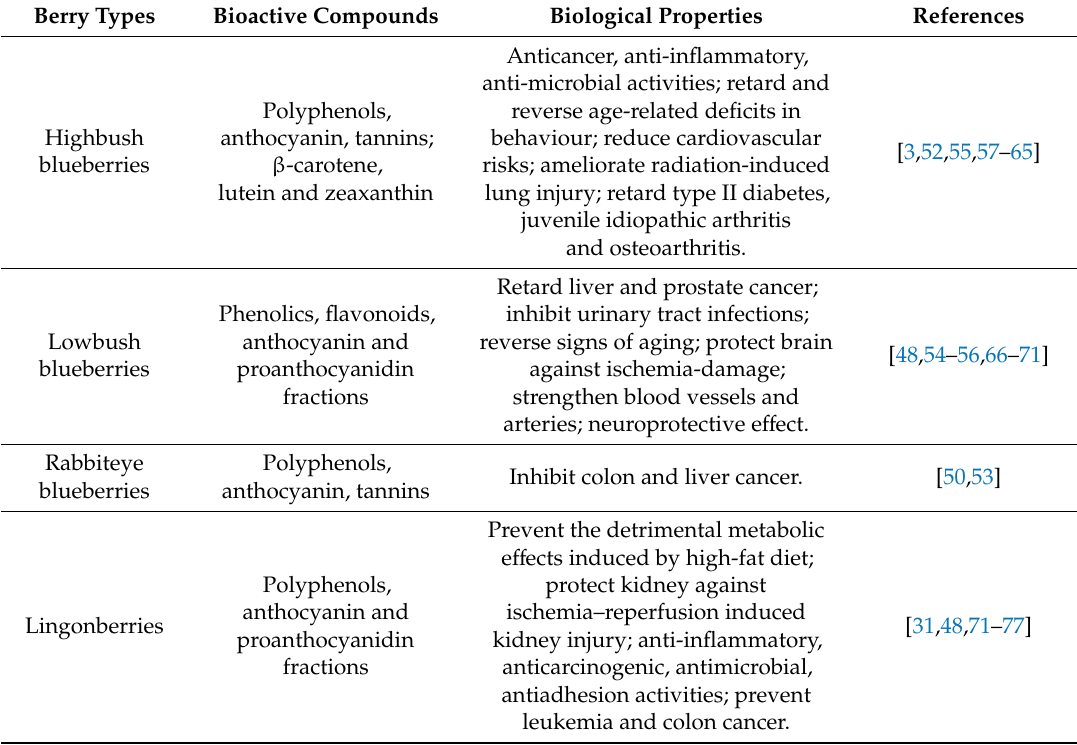
Table 2. Bioactive compounds in Vaccinium berries and their biological